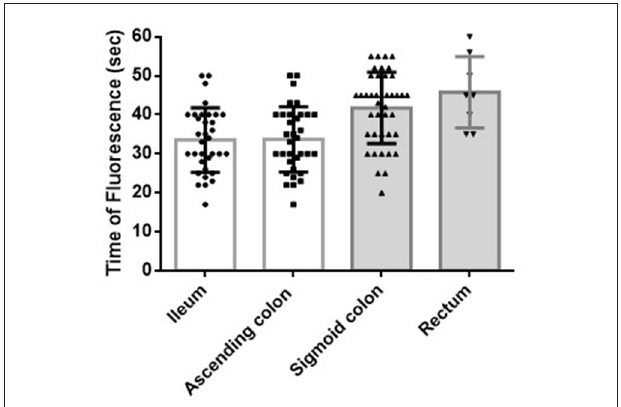
FIGURE 2 | Blood flow of the bowel stumps during ICR or AR. The FT of the ileal and ascending colon stumps during ICR was 33.5 ± 8.1s and 33.7 ± 8.2s, respectively ( p = 1.000). The FT of the sigmoid colon and rectal stumps during AR was 41.8 ± 9.1s and 45.8 ± 9.3s, respectively ( p = 0.642). The FTs during AR (of both the sigmoid colon and rectal stumps) were significantly longer than the FTs during ICR (of both the ascending colon and ileal stumps: sigmoid colon vs. ascending colon, p = 0.001; sigmoid colon vs. ileum, p = 0.001; rectum vs. ascending colon, p = 0.003; rectum vs. ileum, p = 0.003). ICR: ileocecal resection; AR: anterior rectal resection; FT: fluorescence time (time from indocyanine green injection and injection route flush to the time at which the strongest fluorescent signal was observed in the